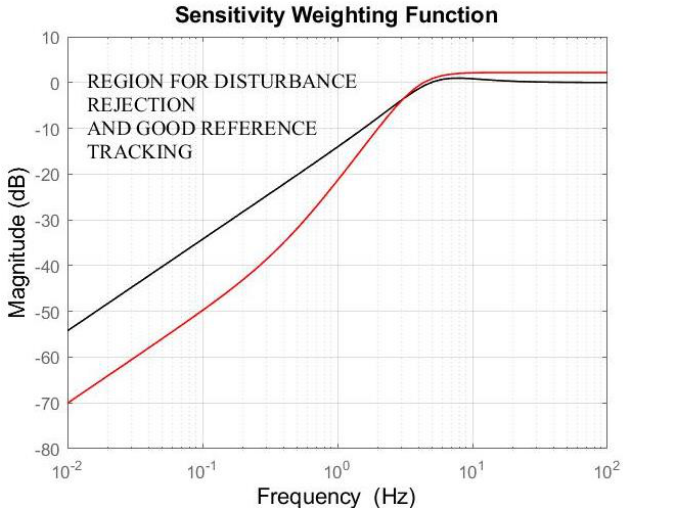
Figure 4. W S ( s ) Weighting Function—Black line: Sensitivity function; Red line: Weighting